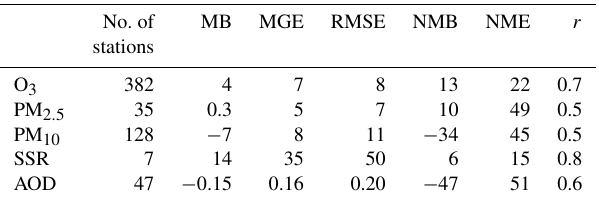
Table 4. Statistical summary of model performance evaluation for summer 2010. The units for MB, MGE and RMSE are in ppb for O 3 , in µgm − 3 for PM and in Wm − 2 for SSR, while the units for NMB and NME are in